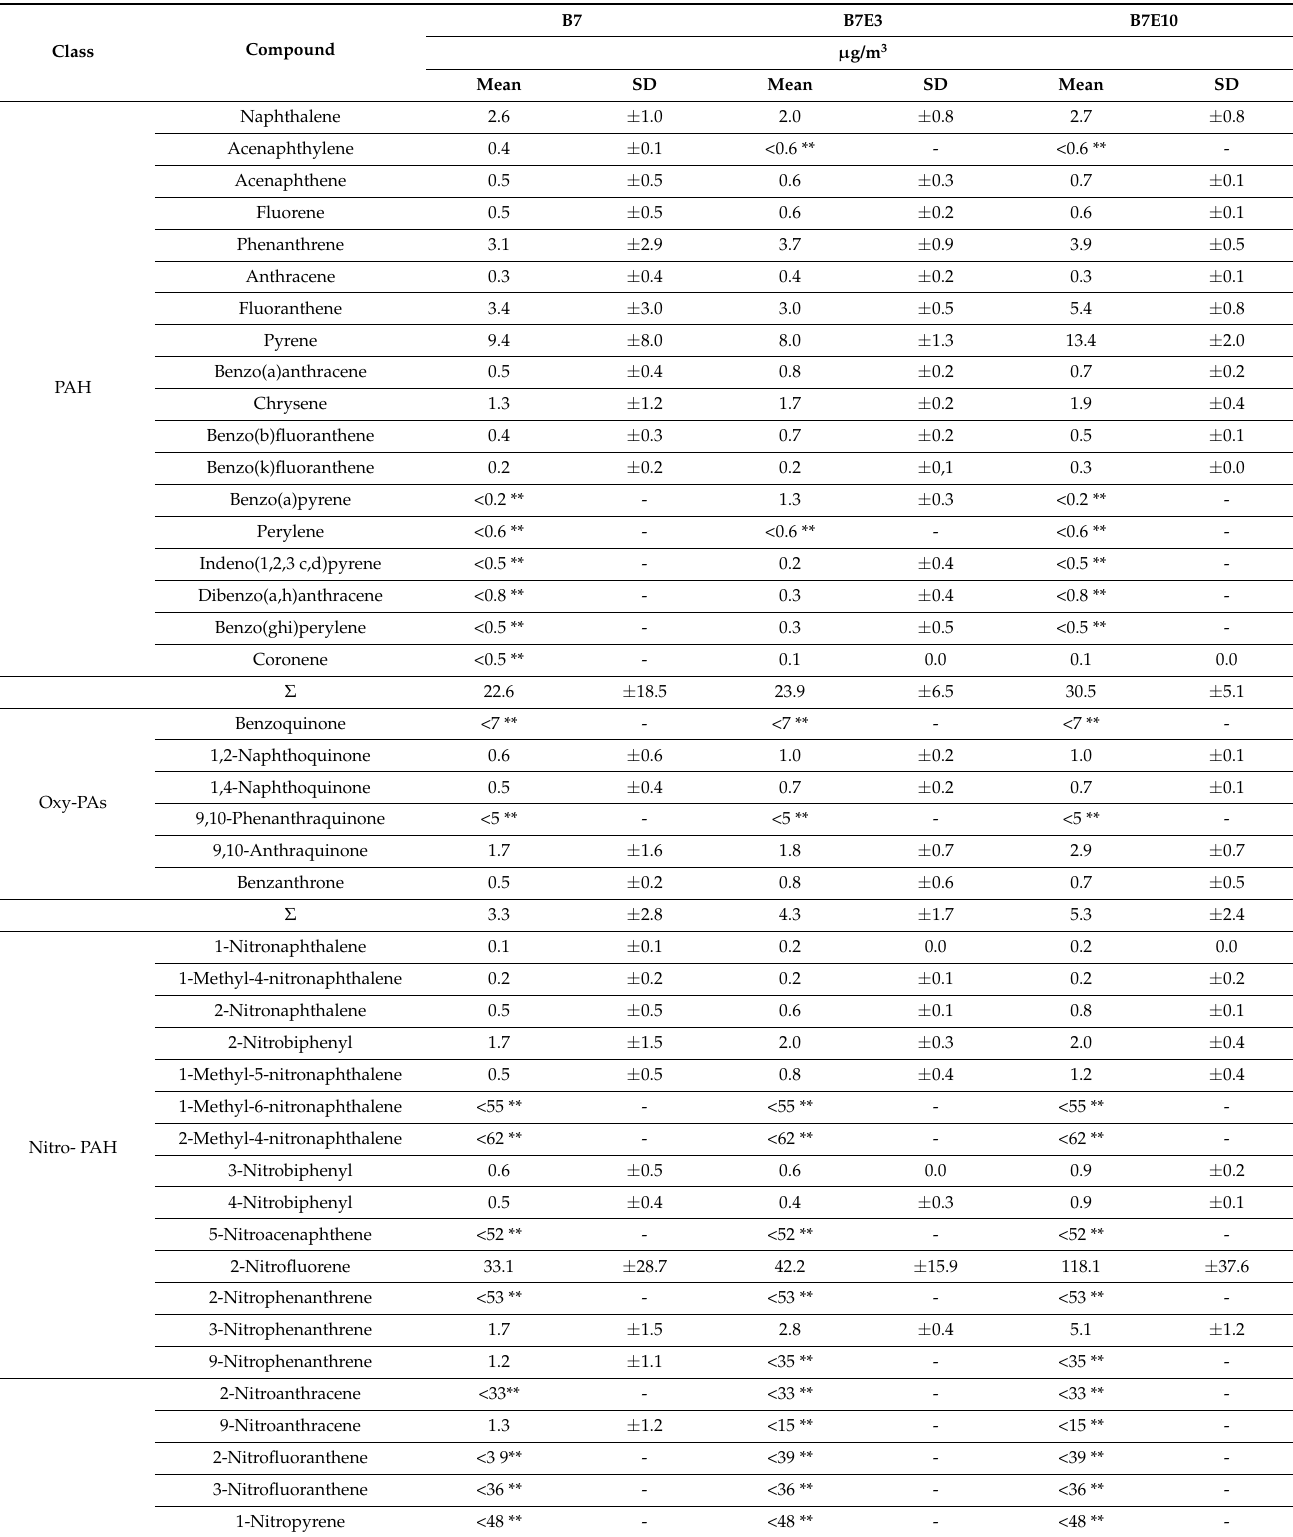
Table 3. Concentrations of PAH, quinones, and nitro-PAH ( µ g m − 3 ) in PM 1.0